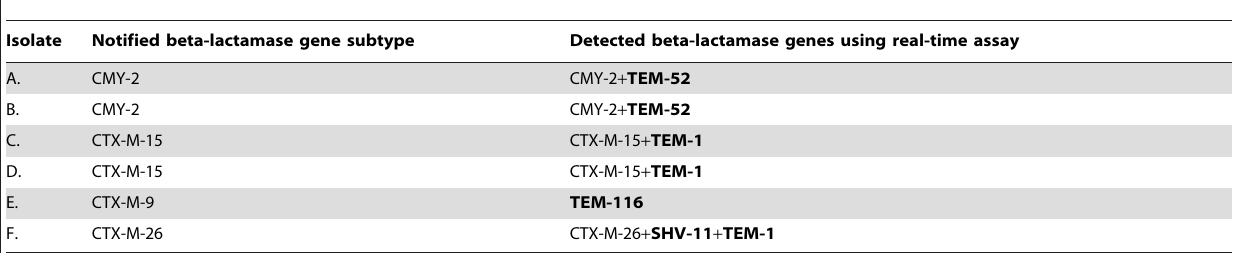
Table 5. Detected differences between the previously notified beta-lactamase gene subtype and the real-time results among the 114 used control